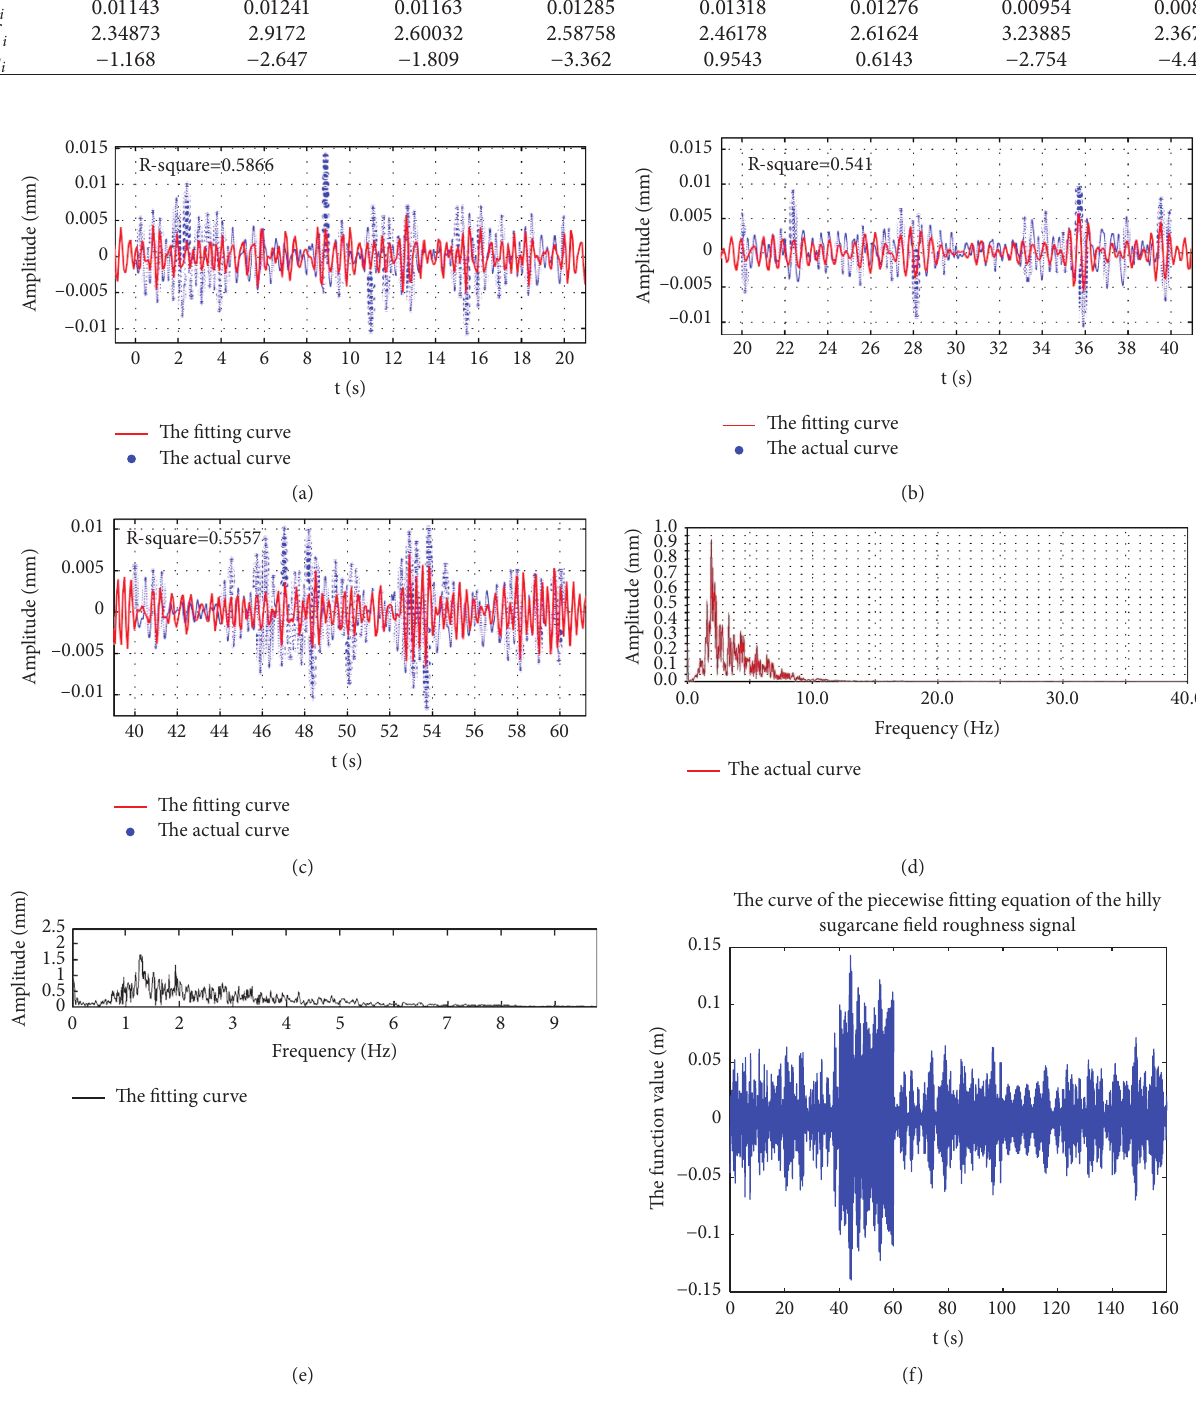
Figure 1: The fitting effect and curves of equation (1) in the frequency and the time domains. (a) The fitting effect of equation (1) in 0 ∼ 20s. (b) The fitting effect of equation (1) in 20 ∼ 40 s. (c) The fitting effect of equation (1) in 40 ∼ 60 s. (d) The amplitude-frequency curve of the hilly sugarcane field roughness signal. (e) The amplitude-frequency curve of equation (1). (f) The curve of equation